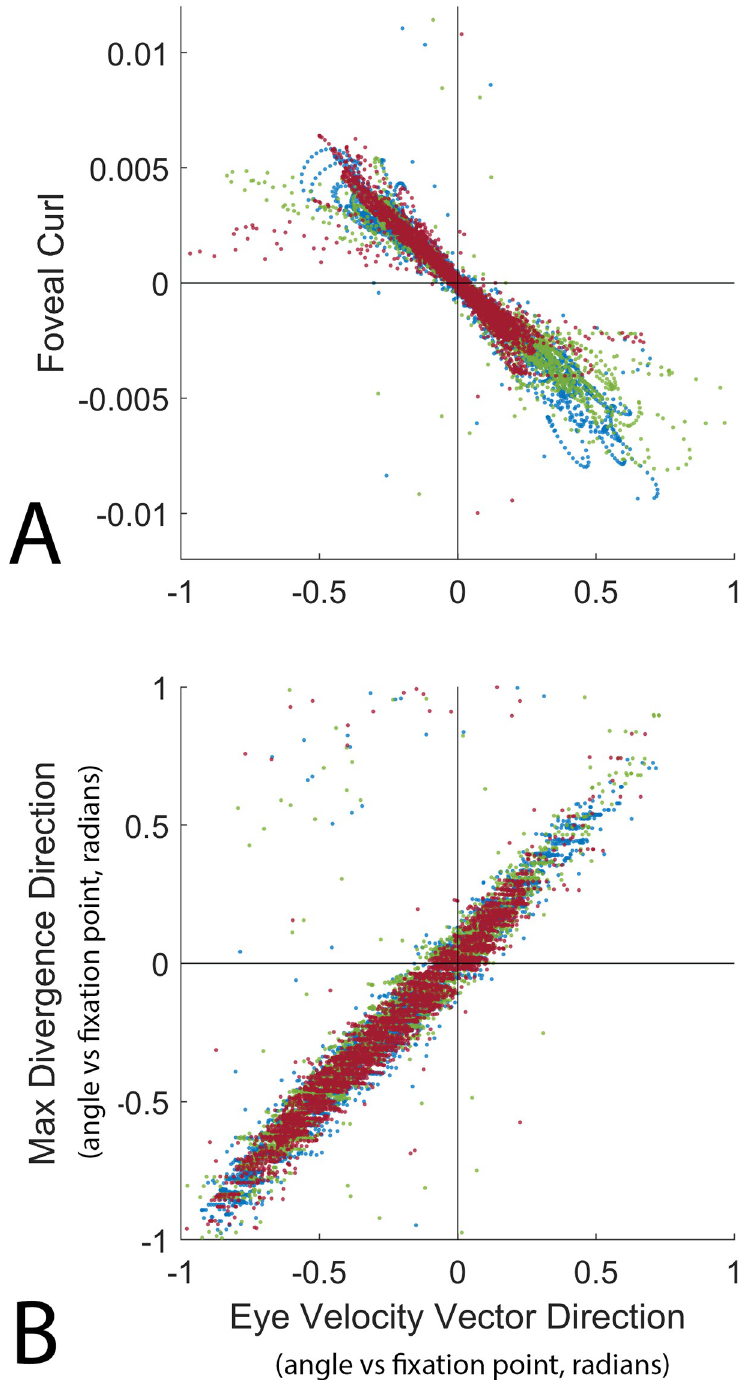
Fig 7. The relationship between curl, divergence, and the angle between the eye’s velocity vector and the fixation point. The x-axis in A & B shows the angle between the vertical projection of the eye’s velocity vector and the fixation point, with zero denoting that the eye’s instantaneous velocity vector passes directly through the point of fixation on the ground, negative values mean the eye will pass to the left of the fixation point, and positive values mean the eye will pass to the right. The Y-axis of (A) represents the curl of the retinal flow field at the fovea (foveal curl). Each dot represents a single recorded frame from S10 Video, with the different colors denoting data from the three subjects. The Y-axis of (B) shows the angle between the point of maximum divergence in the retinal flow field and the point of fixation, measured similarly to the angle between the eye vector and the fixation point on the x-axis.